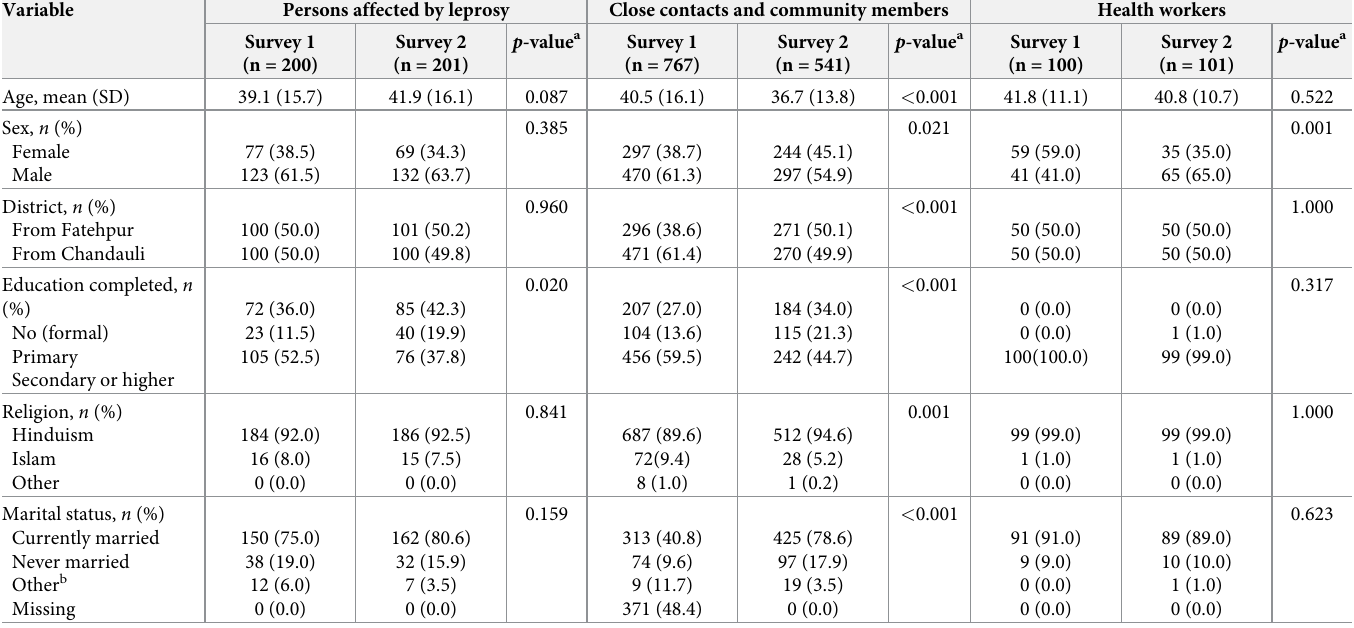
Table 2. Overview of the demographic characteristics of the participants included in Survey 1 (before any intervention, n = 1067) and Survey 2 (after the posters and community meetings, n = 842). Variable Persons affected by leprosy Close contacts and community